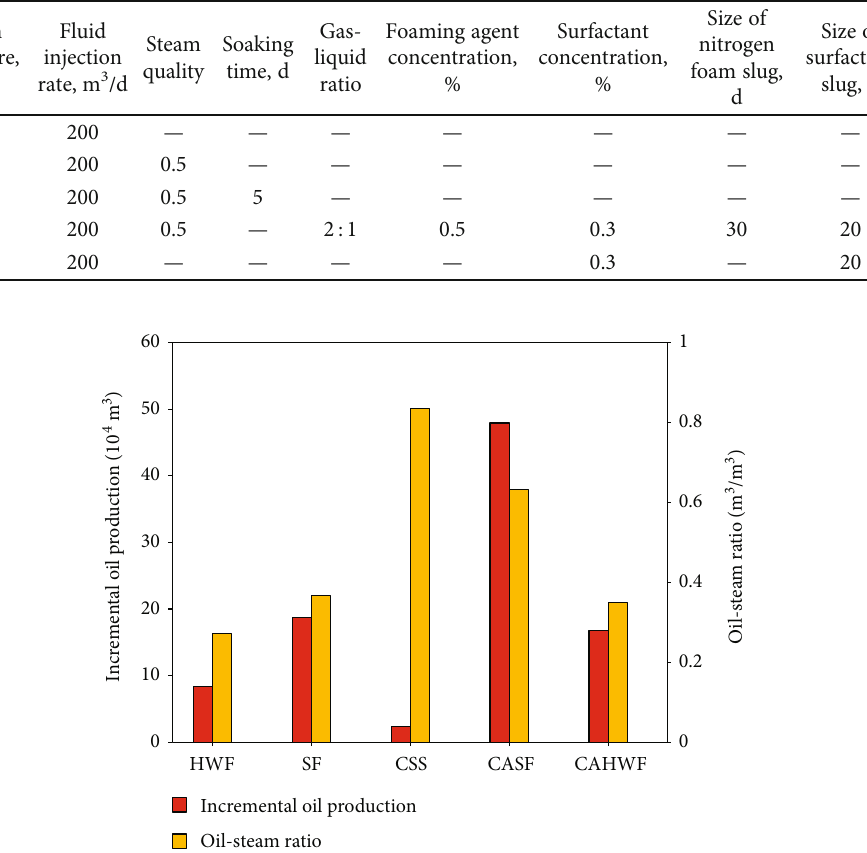
Figure 4: Simulation results of CASF and various thermal methods.